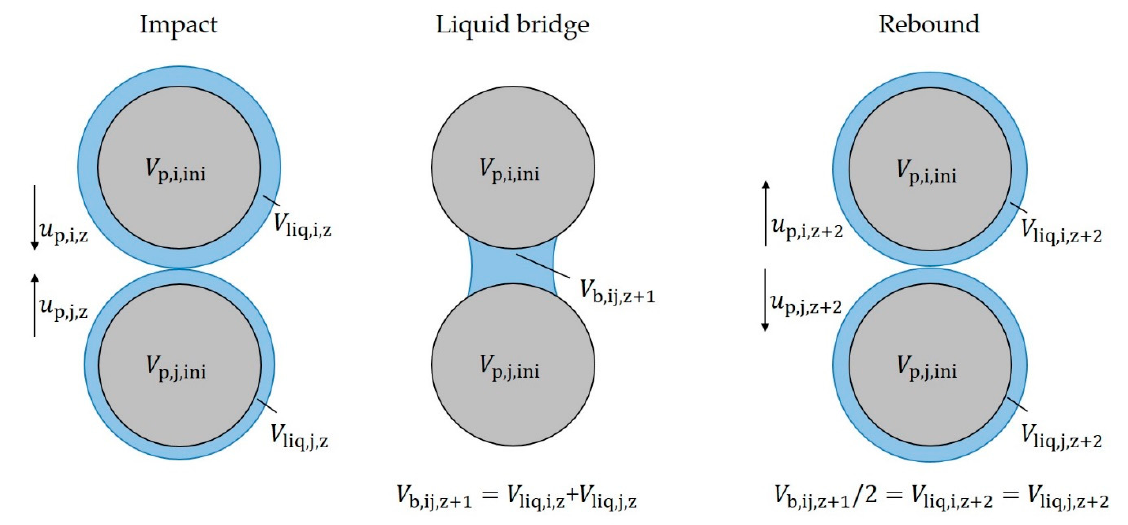
Figure 1. Liquid transfer between two colliding particles, where both particles have a liquid volume.